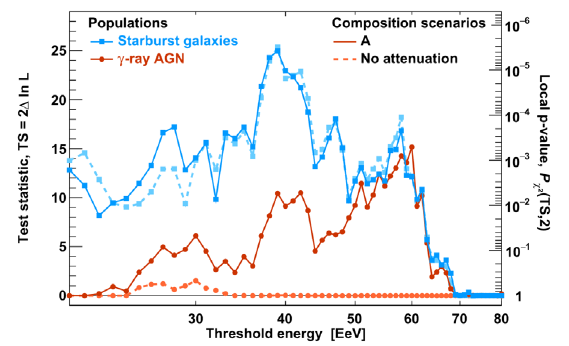
Figure 8. Test statistic (TS) scan over the threshold energy for SBGs and γ -AGNs. The continuous lines indicate the values of the test statistics obtained accounting for attenuation of the inten- sity due to energy losses while the dotted lines refer to the values without any attenuation.